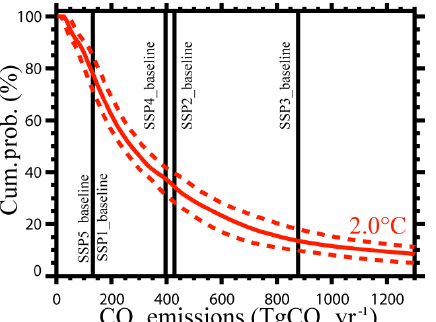
Figure 7. The red curves are the cumulative probability function of CO 2 emissions (TgCO 2 yr − 1 ) in June–November of 2006–2016 for the 2.0 ◦ C runs. Solid and dashed lines denote the 50% values and the 10%–90% confidence intervals, respectively. The vertical lines indicate annual land-use CO 2 emission scenarios for the year 2100 (including fire emissions of CO 2 ) for the east and south-east Asia regions, except China and Japan, for the five SSP baseline scenarios of the AIM/CGE